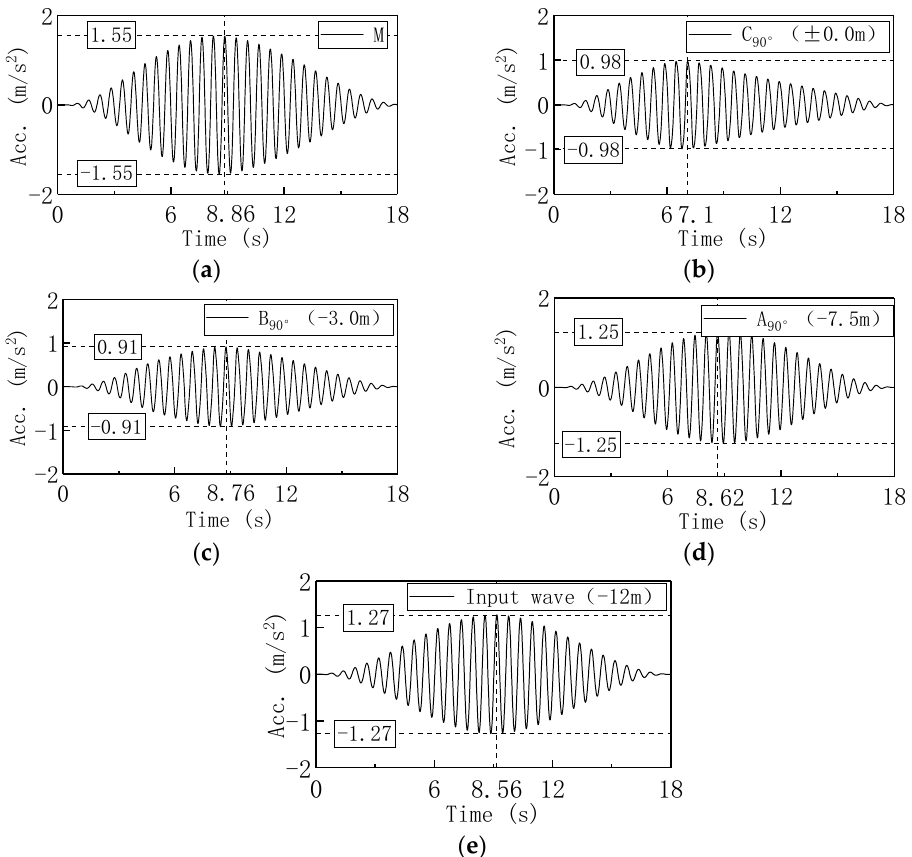
Figure 10. Time history of acceleration in the ground (90°): ( a ) At the position of superstructure; ( b ) At the position of 0.0 m; ( c ) At the position of − 3 m; ( d ) At the position of − 7.5 m; ( e ) At the position of − 12 m.